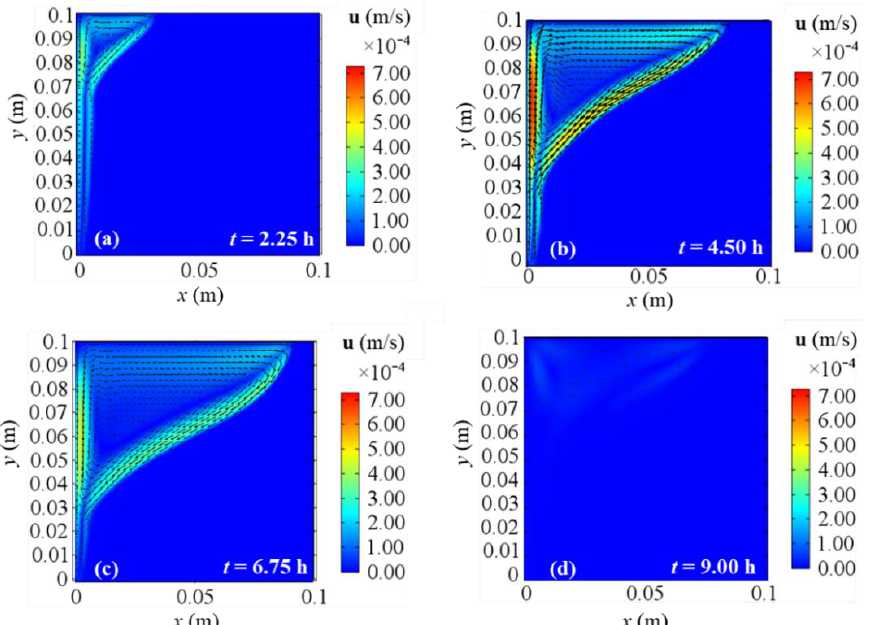
Figure 10. Velocity fields for 2D model with natural convection and BC 1 at different evaluation times: ( a ) after 2.25 h; ( b ) after 4.50 h; ( c ) after 6.75 h; ( d ) after 9.00 h from the simulation beginning respectively.